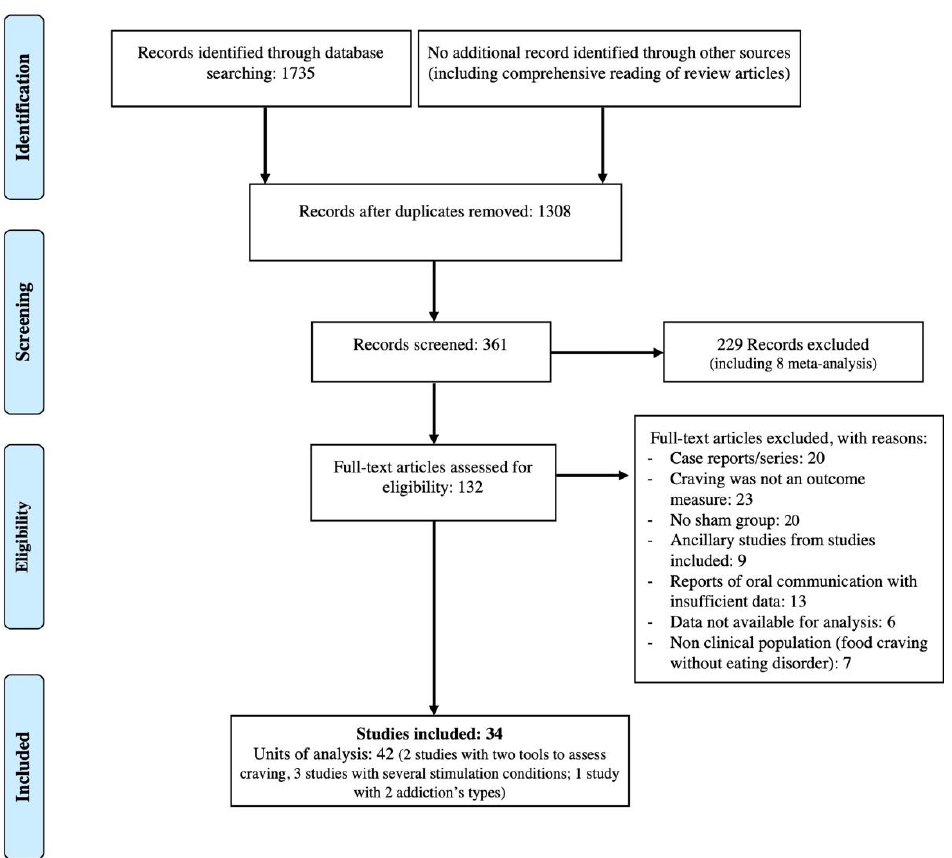
Figure 1. PRISMA flow diagram for the study selection process.